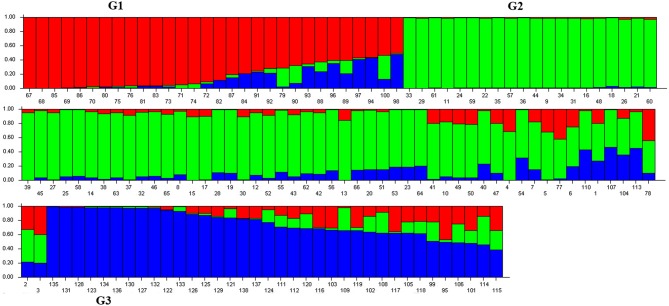
Population structure analysis of 138 M. sinensis individuals from southwest China. Numbers on the x-axis indicate the individual and numbers on the y-axis show the group membership. G1, G2, and G3 represent the identified structure groups.